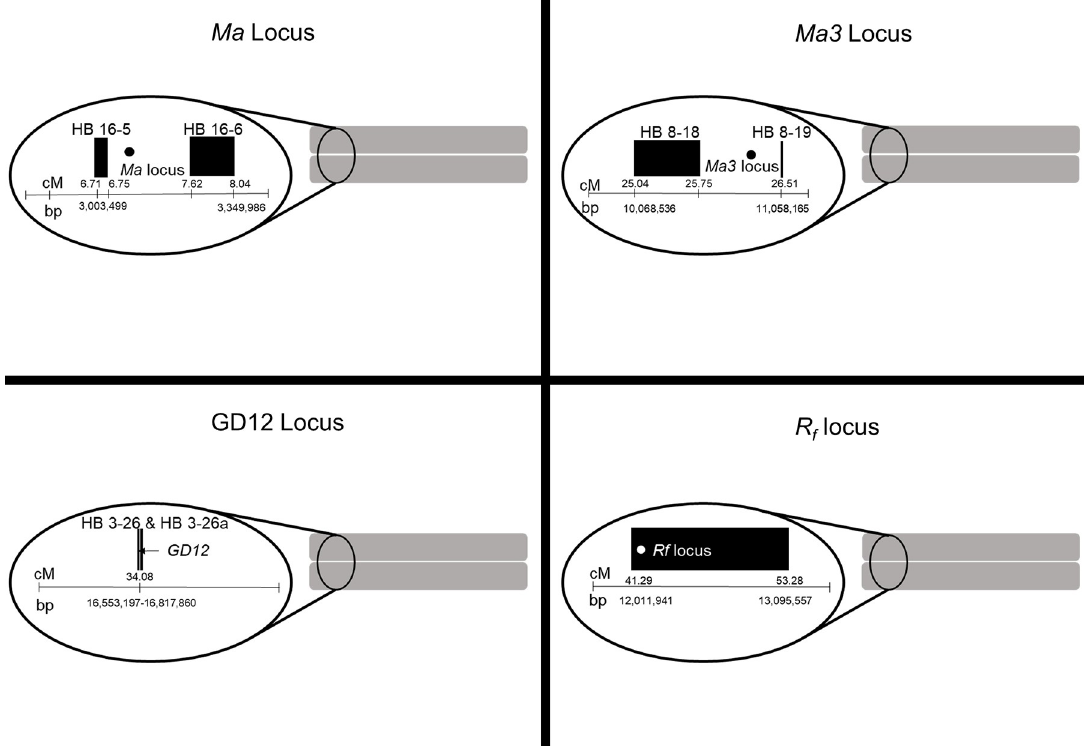
Fig 3. Location of each locus in relationship to flanking haploblocks. Upper left is the Ma locus in apple, upper right is the Ma3 locus in apple, lower left is the GD12 locus in apple, and lower right is the R f locus in sweet